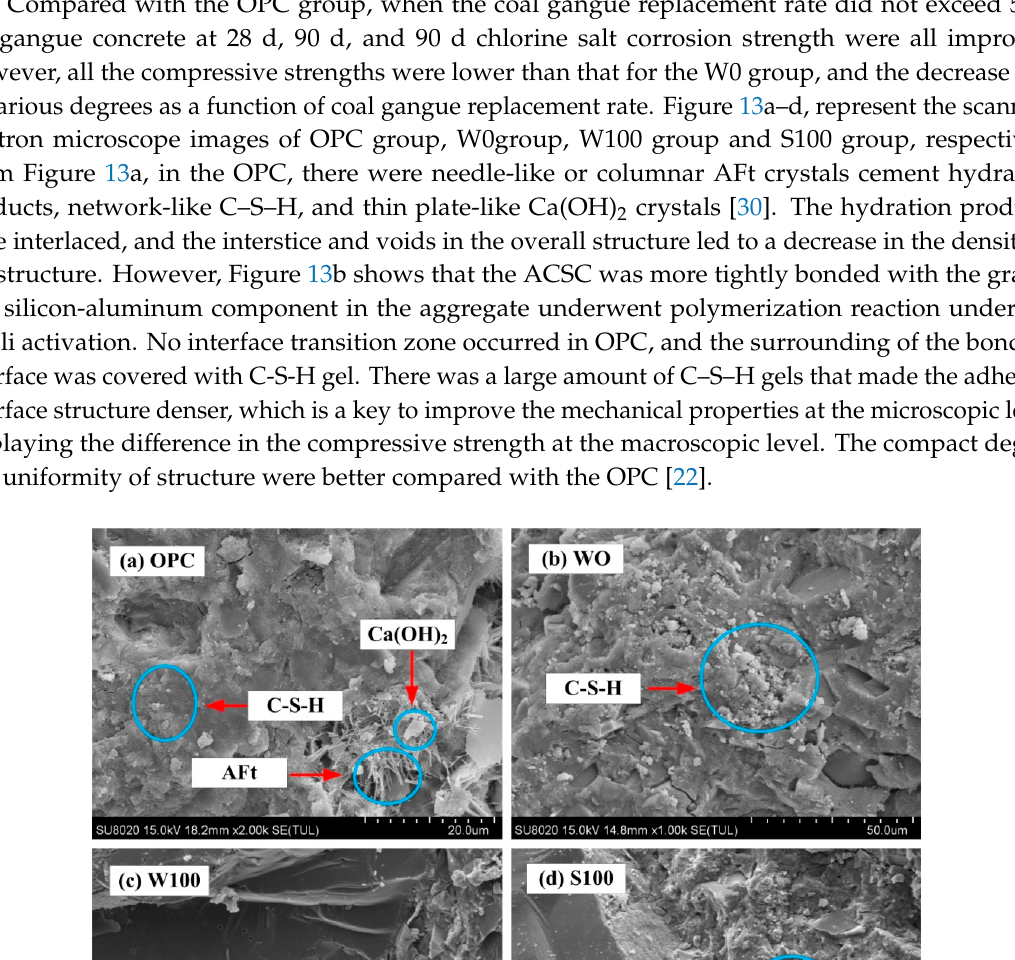
Figure 12. SEM diagram of coal gangue aggregate.